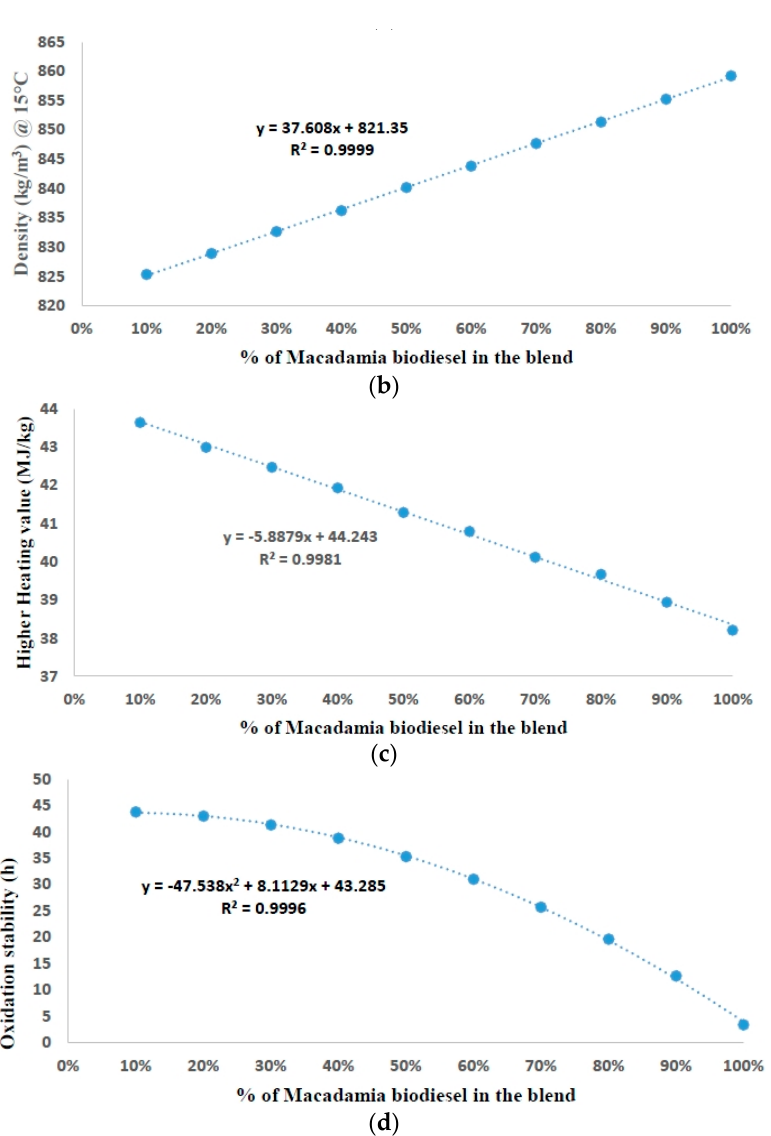
Figure 5. Effect of macadamia biodiesel–diesel blending on ( a ) KV ; ( b ) D ; ( c ) higher heating value ( HHV ); and ( d ) OS .